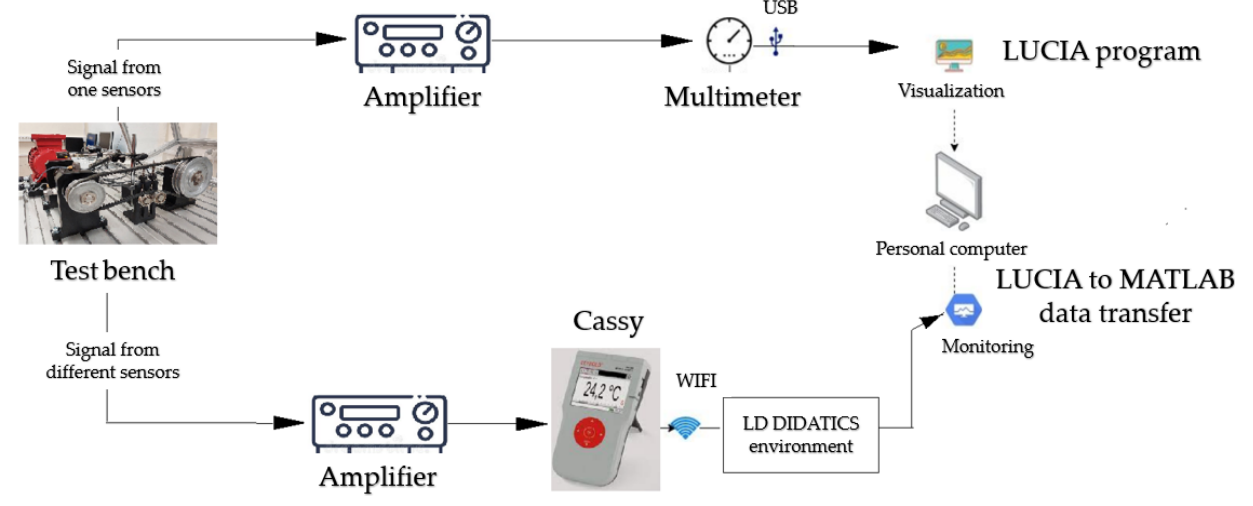
Figure 9. Condition-monitoring scheme of using custom Lucia program.